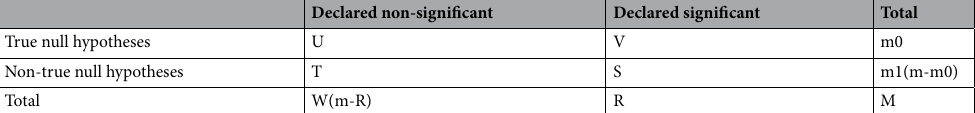
Table 1. Results of multiple hypothesis testing. m is the number of hypothesis tests, and the number of genes in gene chip data. m0 is the true and m1 is the false null hypothesis, where m1 = m-m0. After testing the m (null) hypothesis, it is declared that R is significant, and W (W = m-R) is non-significant null hypothesis. U, T, V, and S represent the summation of the judgment of samples in multiple comparisons. According to the judgment rules, m (null) hypotheses were divided into four parts, which are U, V, T and S, where U and S were the correct tests. V and T represented the number of type I and II error tests in m(null)